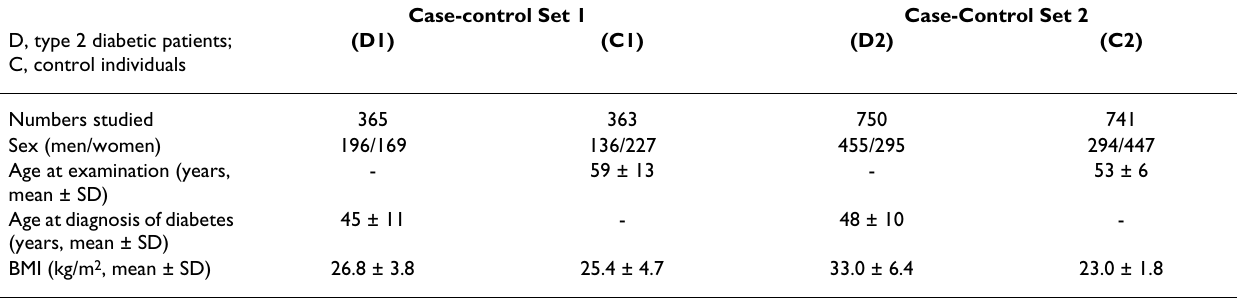
Table 1: General characteristics of the French populations studied Case-control Set 1 Case-Control Set